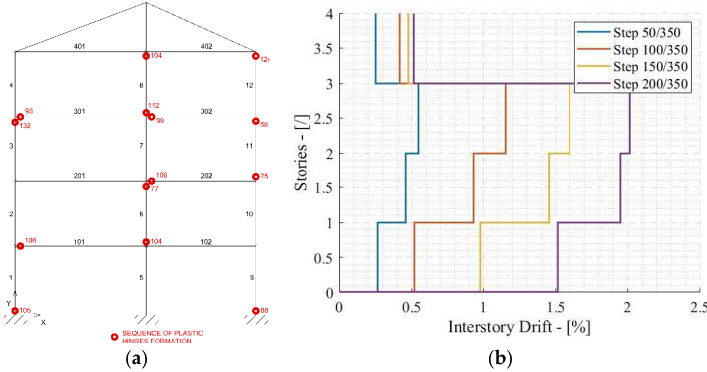
Figure 8. ( a ) Plastic hinges and ( b ) interstory drift at different steps of the pushover analysis.